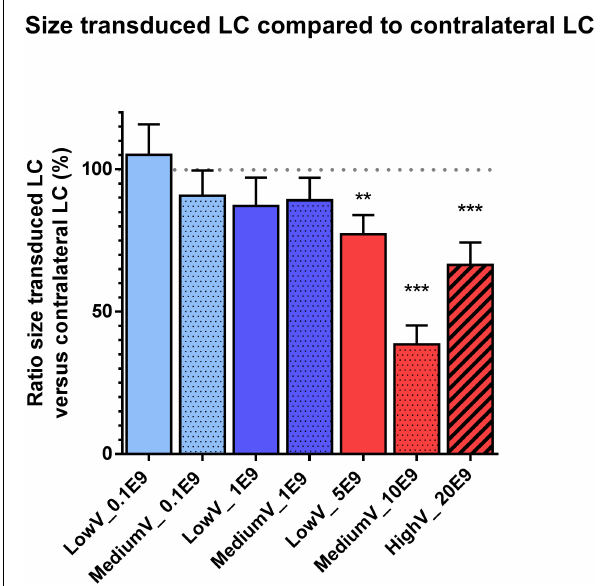
FIGURE 3 | Graphical representation of the size of the transduced LC compared to the contralateral non-transduced LC. A significant decrease in size was observed in all undiluted conditions with the highest decrease in the MediumV_10E9 condition (transduced LC was 38.5 ± 6.7% of the contralateral LC size, p < 0.001). A significant decrease in size of transduced LC was also observed in the LowV_5E9 (77.2 ± 6.7, p = 0.002) and HighV_20E9 (66.4 ± 7.9, p < 0.001) condition. Bars represent the mean difference in LC size ± SEM per condition normalized to the contralateral non-transduced LC (represented by dotted line). Pattern inside the bars represent the injected volume: low, 3 × 300 nl = no pattern; medium, 3 × 600 nl = dotted pattern; high, 3 × 1,200 nl = striped pattern. Colors of the bars represent the dilution: undiluted (5,10,20E9 pp) = red; diluted to 1E9 pp = dark blue; diluted to 0.1E9 pp = light blue. (** p < 0.01, *** p <